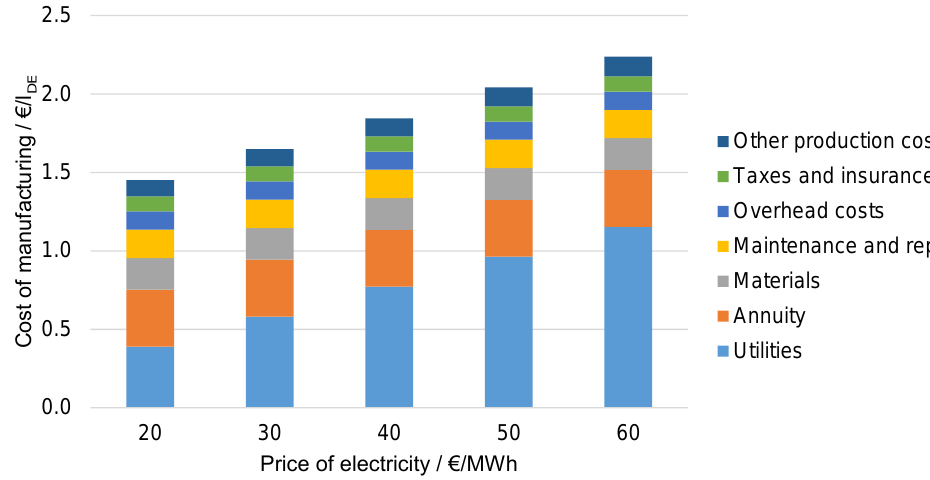
Figure 16. Production costs depending on the electricity price.